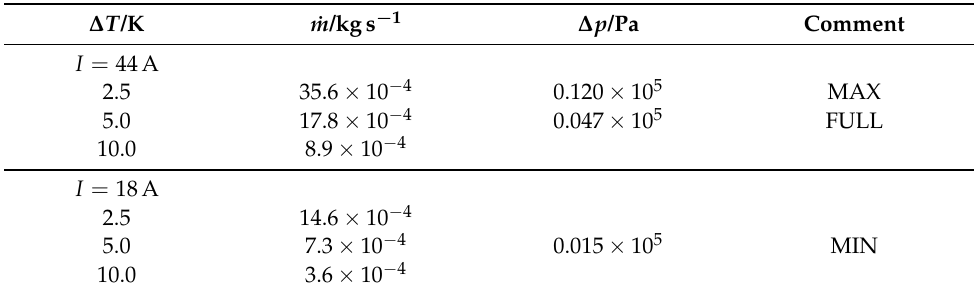
Table 8. Estimated total mass flux and resulting ∆ p for the coolant flow field. ∆ T